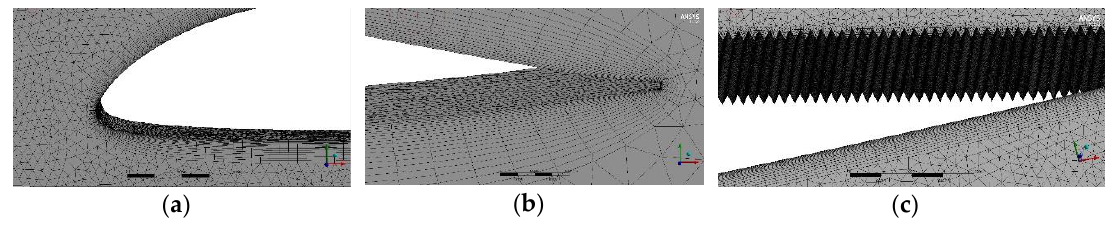
Figure 6. Grid system for computational domain: ( a ) near leading edge region; ( b ) near trailing edge region; and ( c ) near spanwise microgrooved surface region.